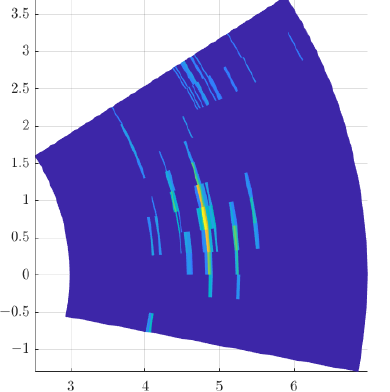
Figure 6. An example of threshold segmentation operation in sonar image processing. In this case, the application of threshold segmentation was not preceded by any pre-processing operation (except for determining the ROI). Therefore, many pixel groups can be seen as a result of this operation [own